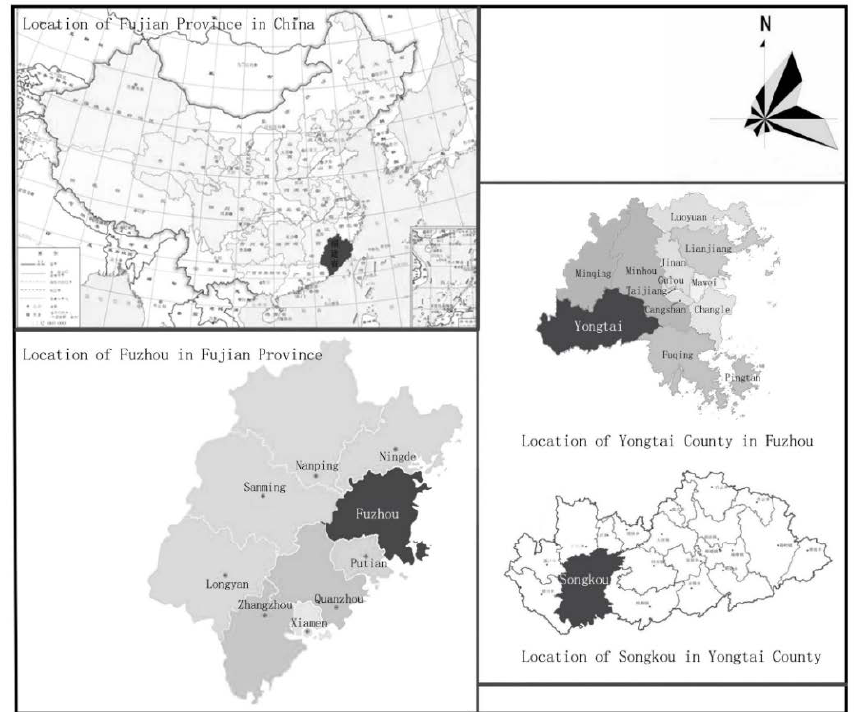
Figure 1. Location of Songkou ancient town.